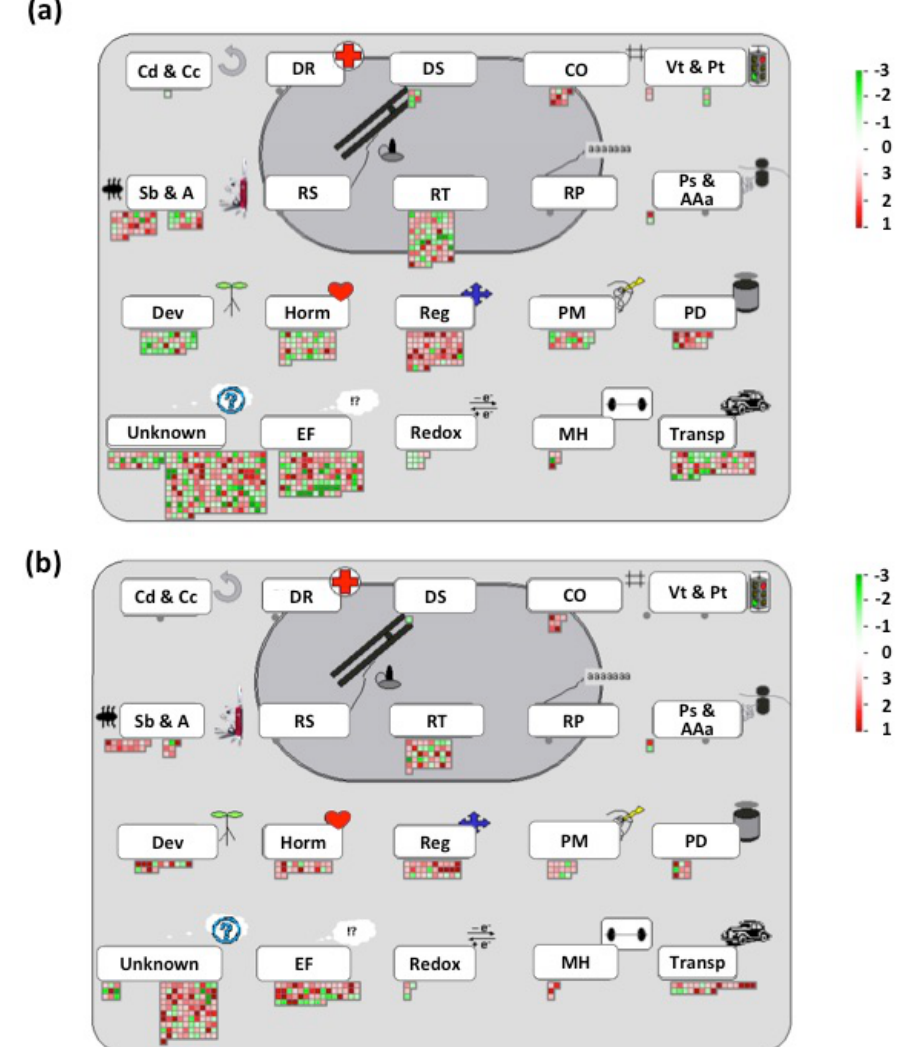
Figure 6. Functional categories affected in Pi-deficient common seedlings inoculated with rhizobia. MapMan regulation overview map showing differences in transcript levels between common bean seedlings growing under OP ( a ) or LP ( b ) conditions and inoculated for 48 h with rhizobia. Fold-changes were false-colored; genes showing higher expression are shown in different scales of red color, whereas genes showing lower expression were colored in green color. The complete sets of genes submitted to MapMan analysis are shown in Tables S2 and S3. Cd and Cc: cell division and cell cycle; DR: DNA repair; DS: DNA synthesis; CO: cell organization; Vt and Pt: vesicle transport and protein targeting; Sb and A: stress biotic and abiotic; RS: RNA synthesis; RT: regulation of transcription; RP: RNA processing; Ps and AAa: protein synthesis and amino acid activation; Dev: development; Horm: hormones; Reg: regulation; PM: protein modification; PD: protein degradation; Unknown: unclassified no ontology and unknown; EF: enzyme families; MH: metal-handling; Transp: transport.